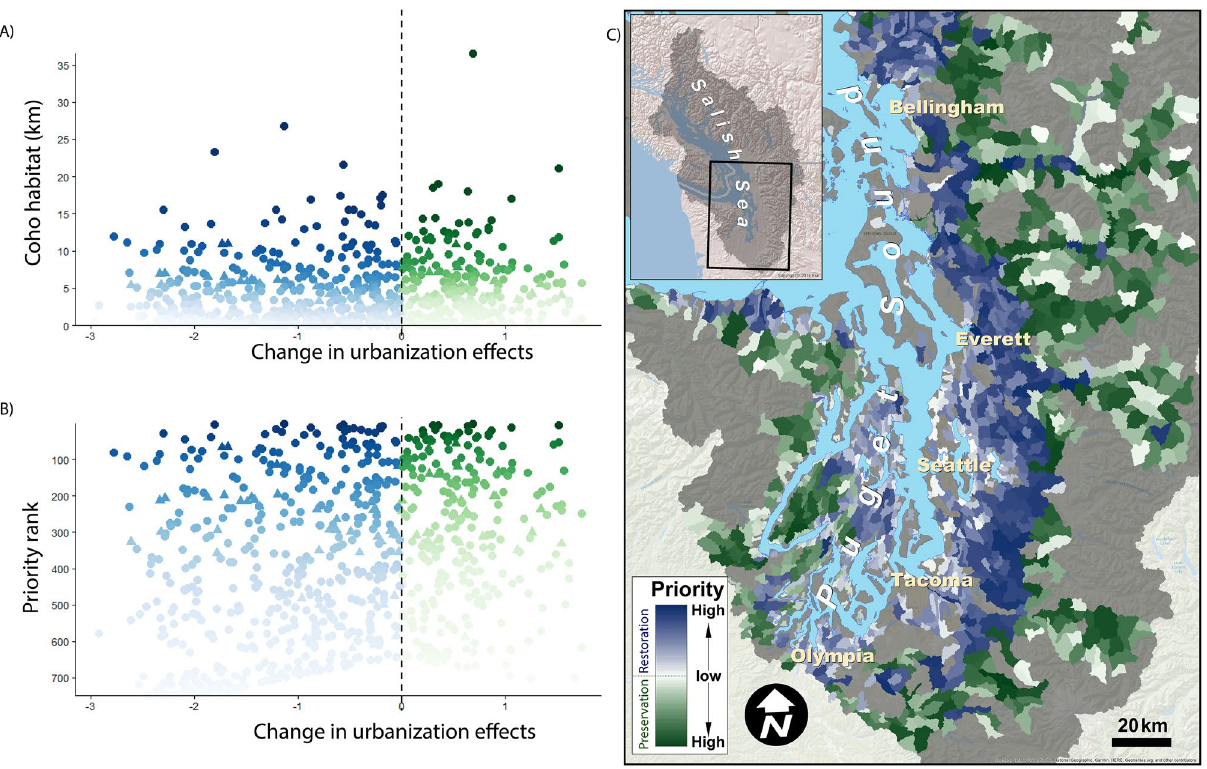
Figure 4. Prioritization of subbasins, using amount of coho habitat as the conservation metric. Subbasins in need of restoration (i.e., Δ Z < 0, N = 953) are shown in blue; those that are candidates for preservation (Δ Z > 0; N = 449) are shown in green, with darker colors representing higher priority. We calculate prioritization scores for each subbasin shown in ( A ) and use scores to rank all locations. For both restoration and preservation subbasins, a lower prioritization score is associated with higher priority (see “Prioritizing sites for conservation or restoration action” in “Methods”). Subbasins are ranked by priority on the y -axis in ( B ) (1 = top priority). ( C ) shows subbasin locations. Coho habitat is quantified as kilometers of stream within the subbasin. Map generated using Esri ArcMap software (v. 10.1, https